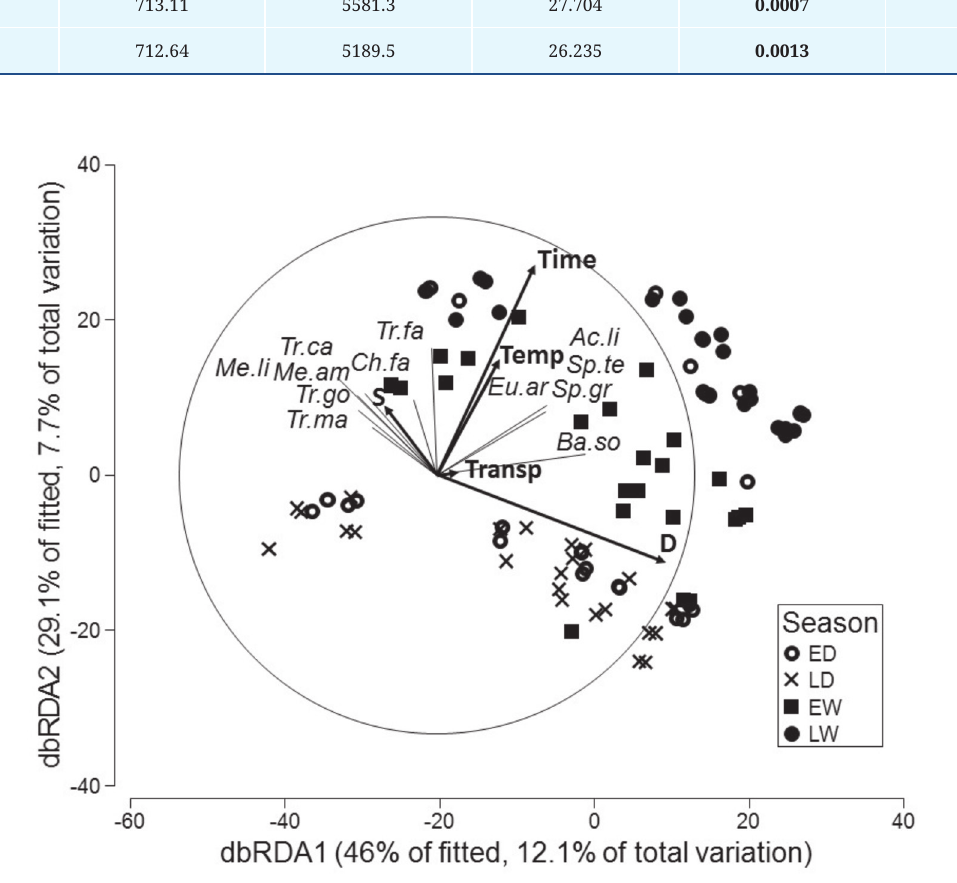
FIGURE 7 | The first two axes from the distance-based redundancy analysis (dbRDA) that correlate the structure of the shallow water fish assemblage and predictors (in bold; from the fitted model) sampled from May 2000 to April 2001 in the north-south axis of the Paranaguá Bay Estuarine Complex (southern Brazilian coast). ED = early dry season (April–June), LD = Late dry season (July–September), EW = early rainy season (October–December) and LW = late rainy season (January–March). Achirus lineatus = Ac.li ; Bathygobius soporator = Ba.so ; Chaetodipterus faber = Ch.fa ; Eucinostomus argenteus = Eu.ar ; Menticirrhus americanus = Me.am ; M. littoralis = Me.li ; Sphoeroides greeleyi = Sp.gr ; S. testudineus = Sp.te ; Trachinotus carolinus = Tr.ca ; T. falcatus = Tr.fa ; T. goodei = Tr.go ; T. marginatus = Tr.ma. Only species with Pearson correlation coefficient | r | ≥ 0.3 with the axes are shown. Percentage explained by the axis (fitted) and total variation explained by the model are provided on the